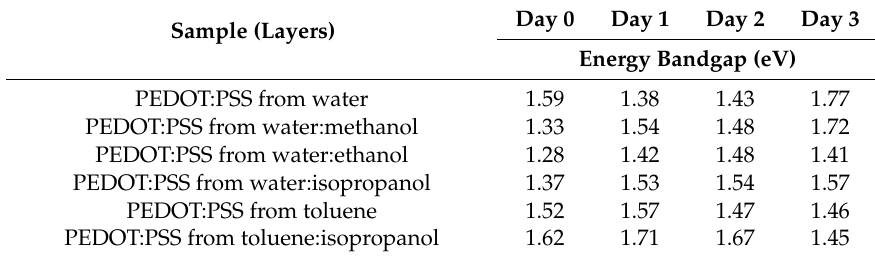
Table 5. The results of energy bandgap values for layers after di ff erent storage periods. Sample